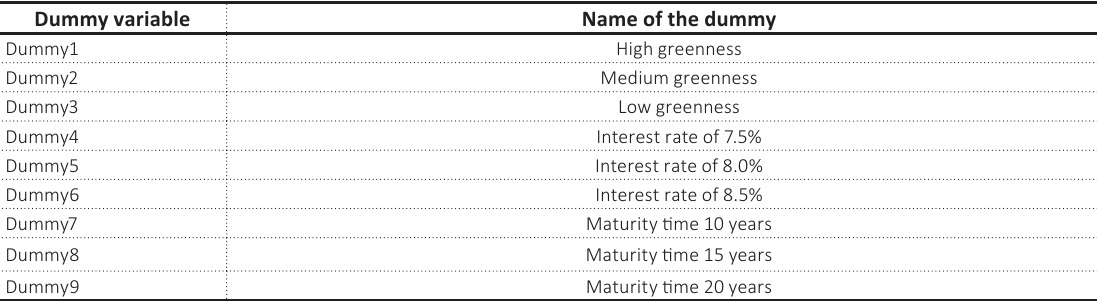
95% confidence interval for Exp(B) Exp(B) Lower bound Upper